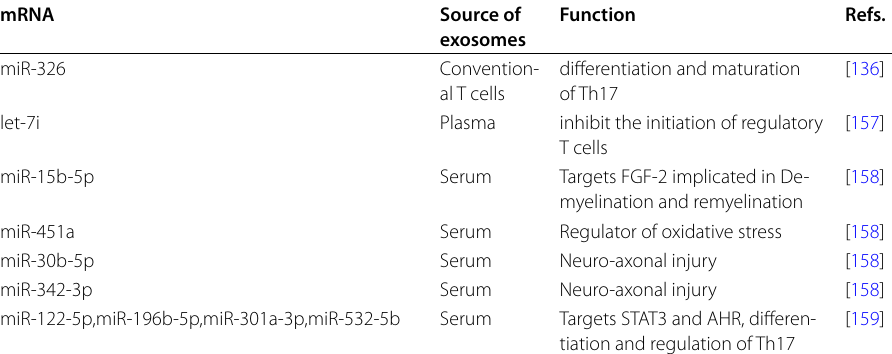
Table 3 Exosomal mRNA as biomarkers in MS